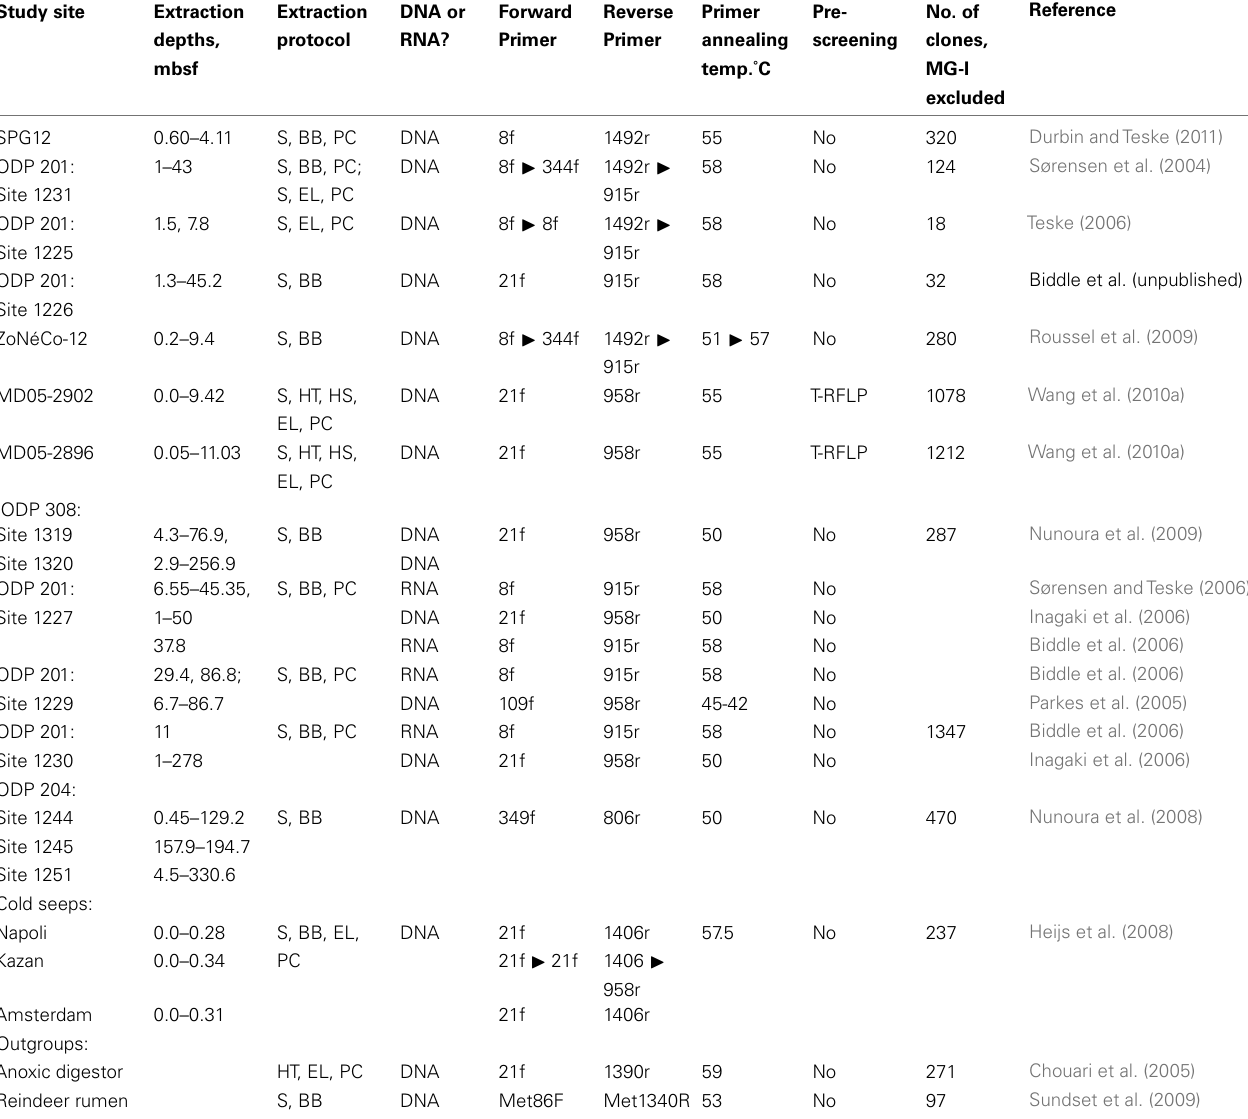
Table 2 | Relevant methodological features for the archaeal clone library studies compared in this review. Study